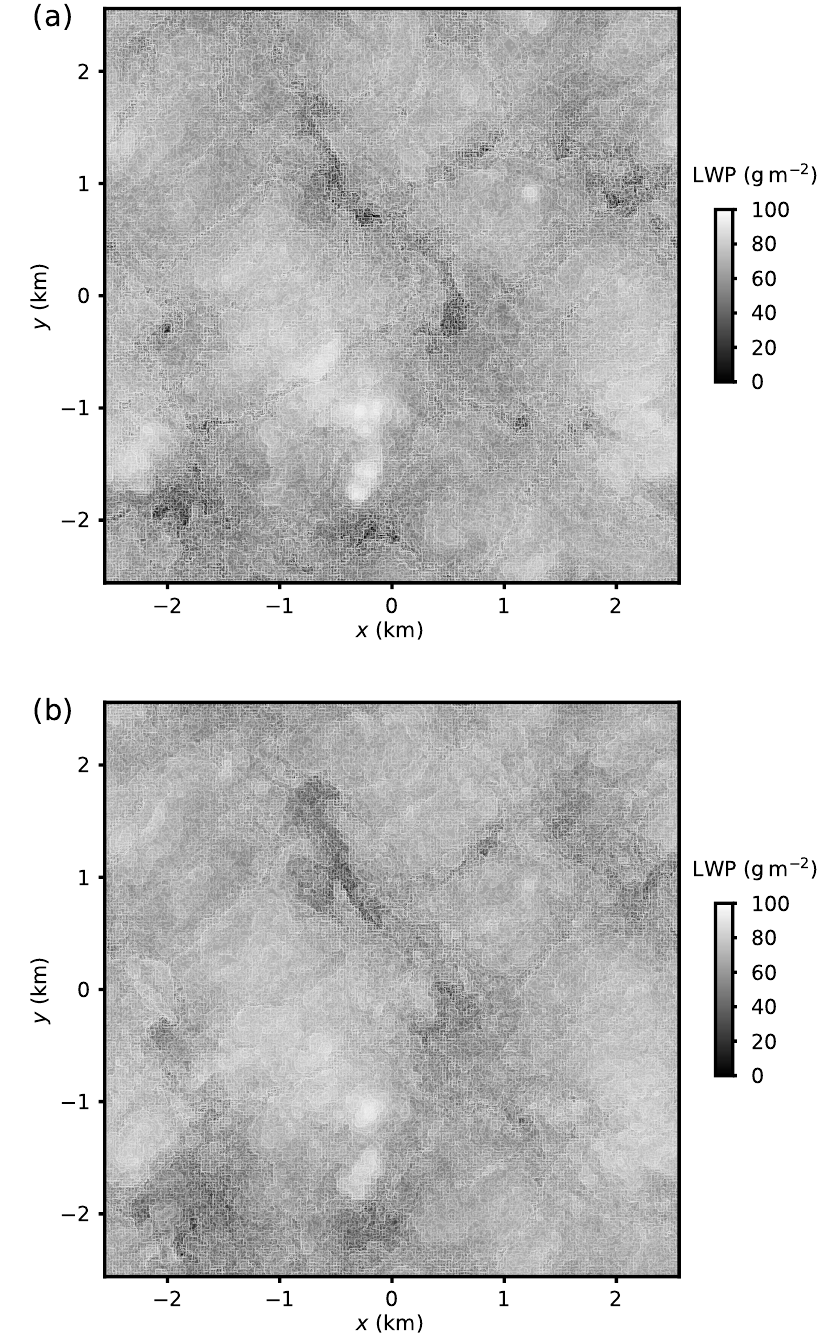
Figure 5. Adjustment of liquid water path structure to the lack of evaporative cooling. Panel ( a ) shows liquid water path (LWP) from a full-physics simulation, Case A1, at t = 2.16 h, and panel ( b ) shows Case M1 LWP. Both simulations were initialized from a full-physics LES at t = 2 h and ran for 10 min. As a result of the relatively short time lapse from the common initial condition, the large-scale LWP structure is similar. The spiderweb LWP structure has shorter time scale and has dissipated in ( b